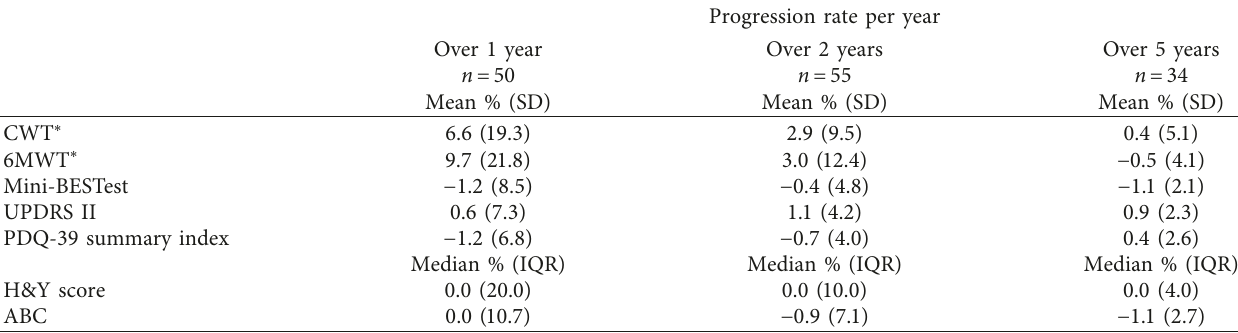
Table 2: Standardized, unadjusted progression rates (in % of maximum score per year or % of baseline score per